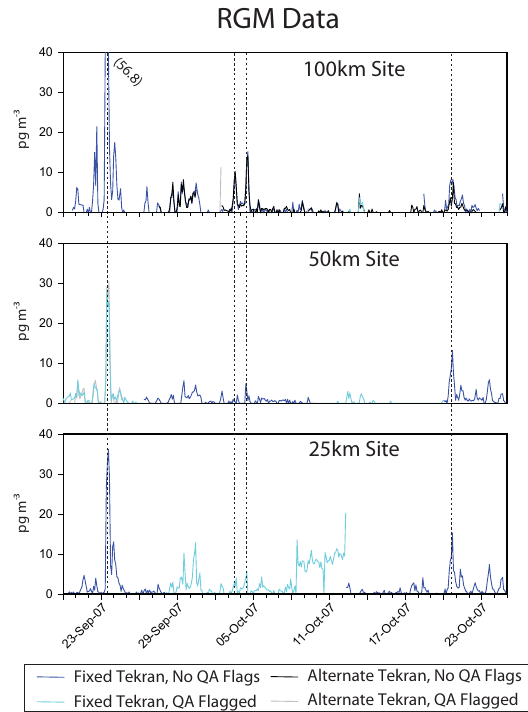
Fig. 3. Mercury speciation for mid-September through October, 2007 showing peak RGM exceeding 50pgm − 3 at the 100km site occurring at 09:35GMT–06:00 on 23 September, and smaller cor- responding RGM peak heights at the 25km site (36.2pgm − 3 ) and the 50km site (28.1pgm − 3 , qualified). The 100km site is the far- thest downwind at this time and date. Results for 4 and 5 October 2007 show a pattern similar to 23 September, with the largest RGM peaks recorded at the 100km site, whereas results for 20 October are consistent with falloff of RGM with distance transported (see